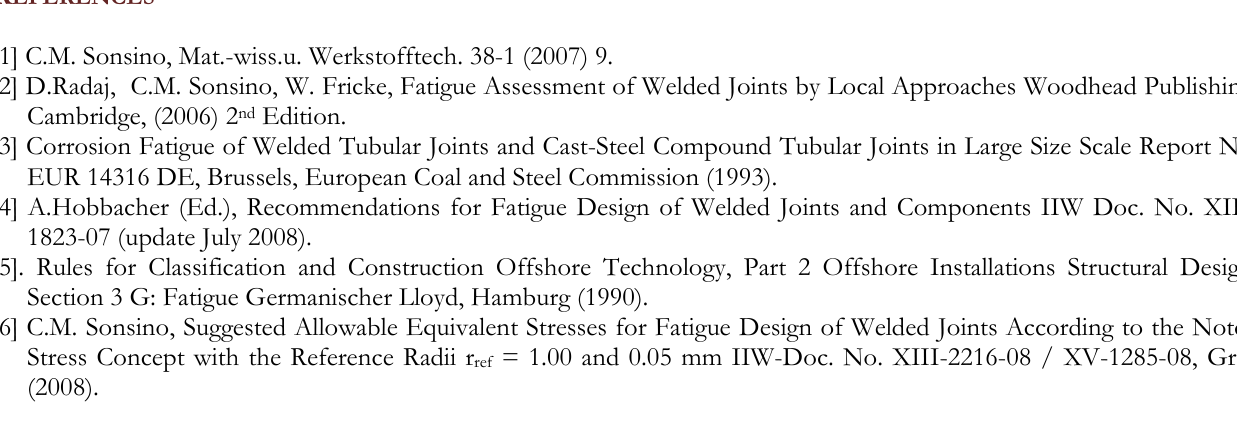
Figure 18: Knowledge interaction for reliable